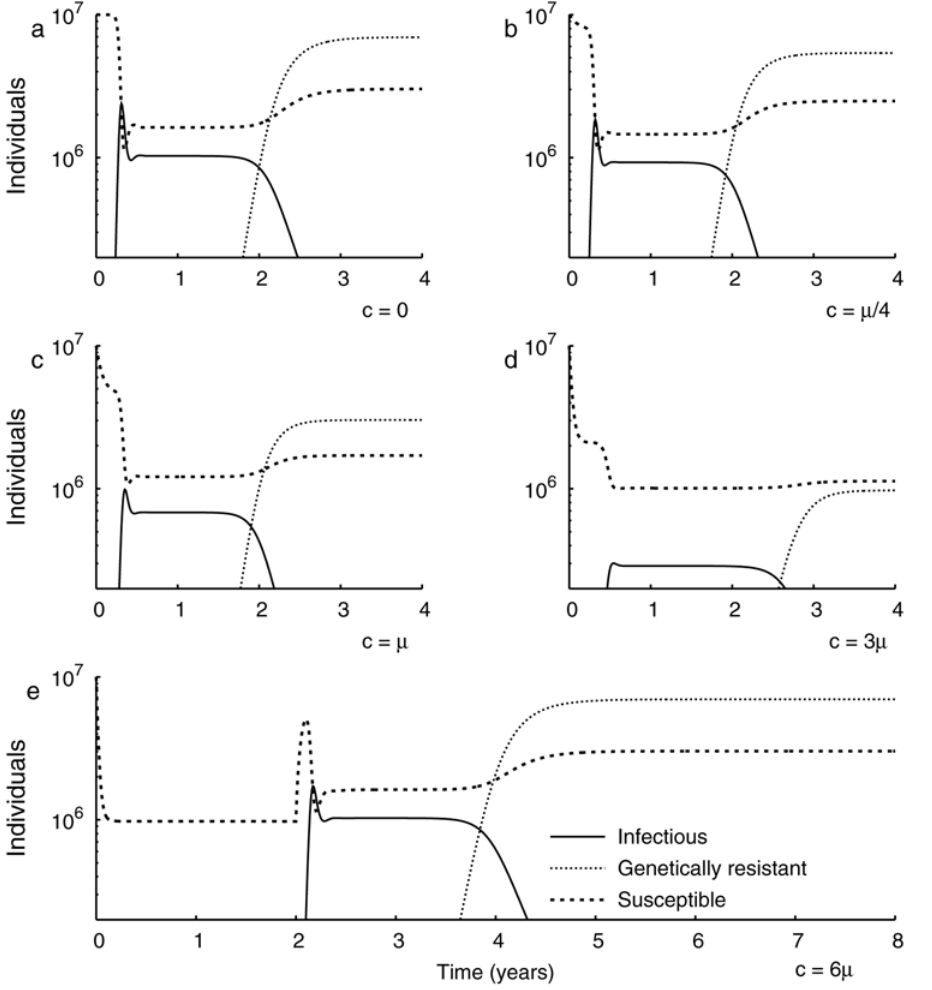
Figure 1. The effect of culling on disease incidence and on the evolution of genetic resistance for continuous culling policies (a–d) and for a policy that discontinues culling after 2 years (e). Increases in the culling rate decrease the transient and influenza incidence ( I ) and the eventual level of genetic resistance of the population ( G z H ). Moderate culling (b,c) may shorten the time for the evolution of genetic resistance compared to no culling (a), but fast culling rates (d) will lengthen the evolution time. Very fast culling rates (e) completely suppress an epidemic, but disease can return when culling is discontinued after 2 years. The simultaneous rebound in the susceptible population corresponds to the abrupt decline in overall